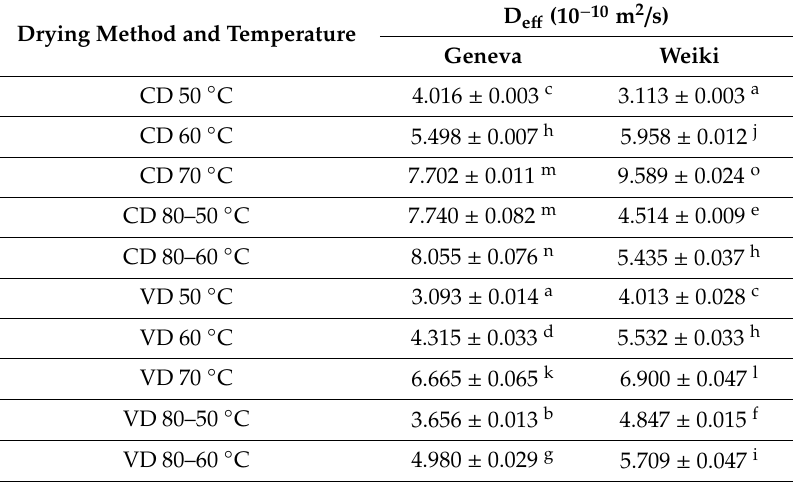
Table 4. E ff ective water di ff usion coe ffi cient computed from simplified Fick’s second law of di ff usion. Drying Method and